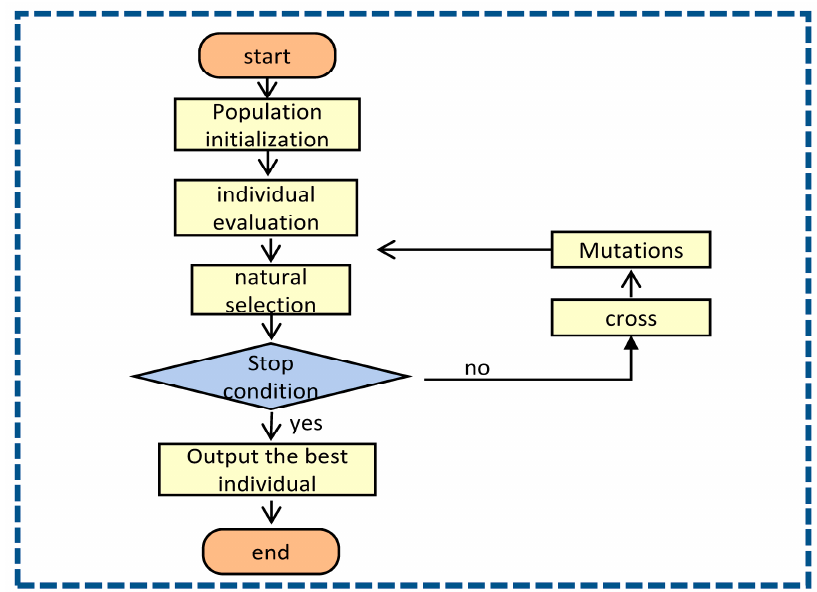
Figure 2. Genetic Algorithm Parameter Optimization Flowchart.